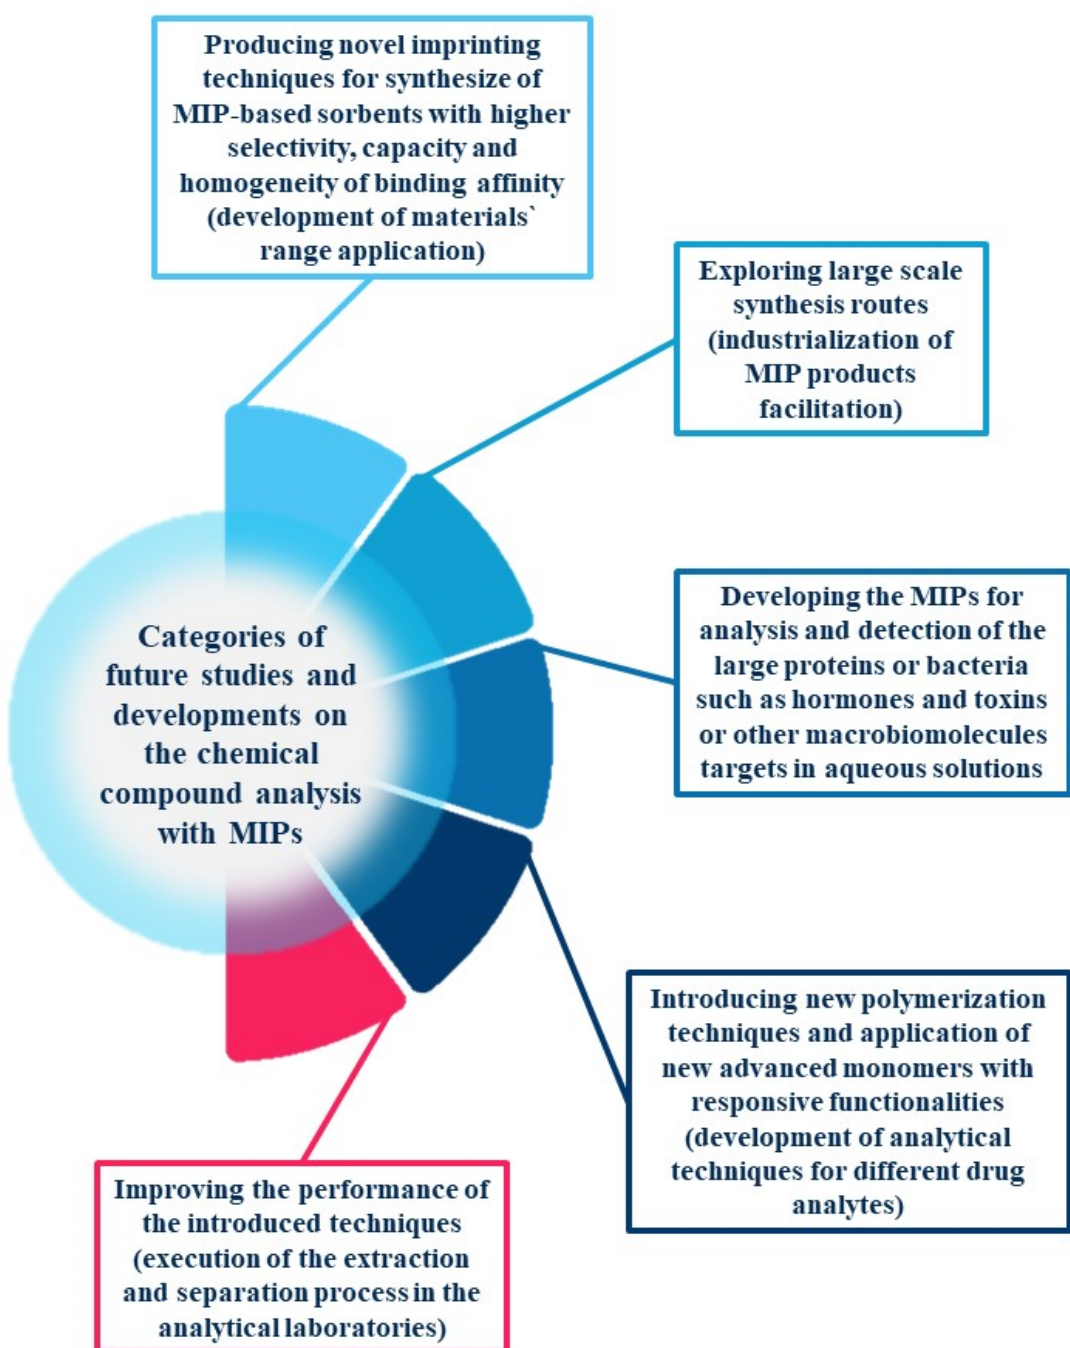
Figure 1. Categories of future research and developments on the chemical compounds analysis with MIPs